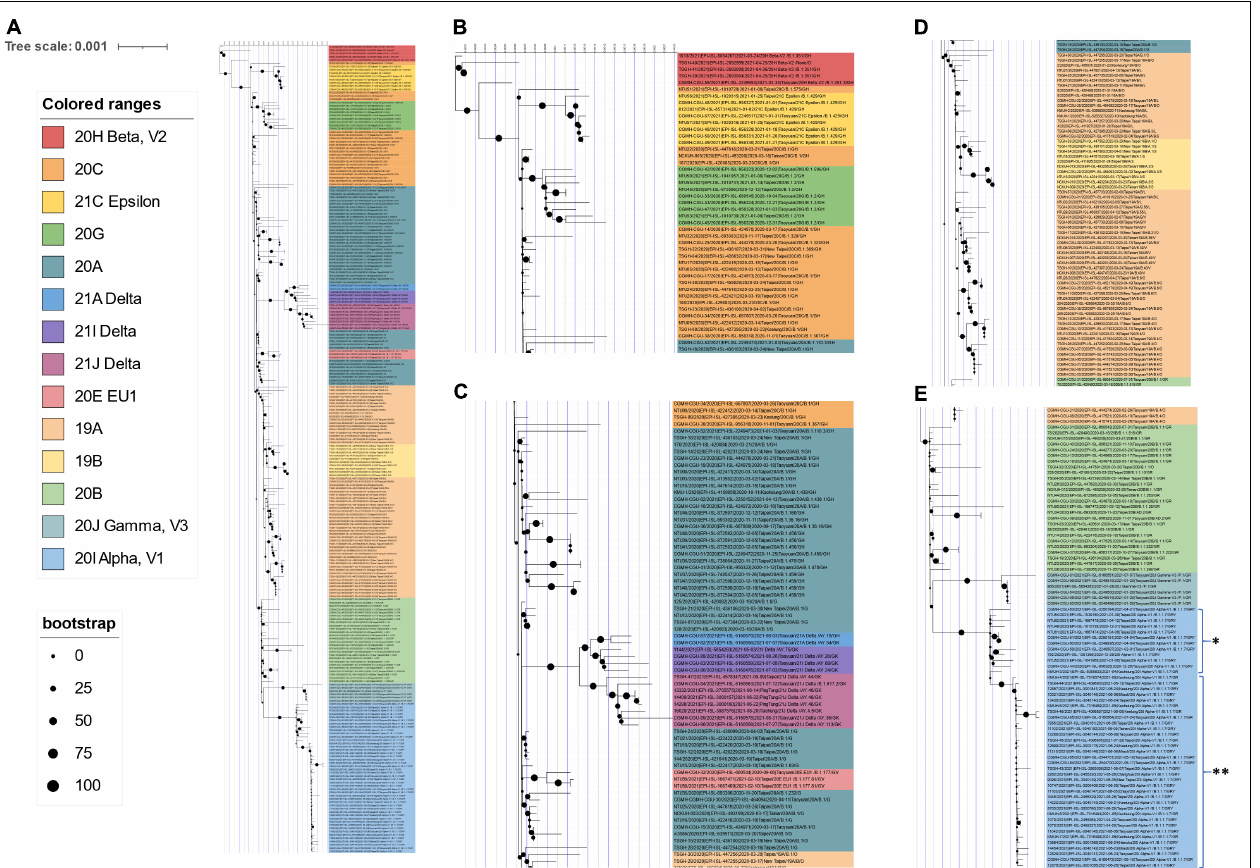
FIGURE 5 | Phylogenetic tree of 247 SARS-CoV-2 genomes collected in Taiwan between January 2020 and December 2021. The phylogenetic analysis was inferred by using the maximum likelihood and fits of 286 different nucleotide substitution models, and the results suggested GTR + F + I as the best-fitting model with the lowest Bayesian information criterion (BIC) scores of 107,672.091 among the 286 models tested. The tree topology was automatically computed to estimate maximum likelihood values. The optimal log-likelihood for this computation was –50,857.073. There was a total of 29,867 positions in the final dataset. The original tree is displayed using iTOL v 6.4.3 (https://itol.embl.de/) (73) with an indicator of bootstrap values and a scale bar. Viruses are shown as the virus name| Accession ID| Collection date| City/Nextstrain_clade/pangolin_lineage/GISAID_clade). (A) An original phylogenetic tree of 247 SARS-CoV-2 sequences obtained from GISAID which samples were collected between January 2020 and December 2021 in Taiwan. (B) A partial tree exhibited phylogenetic correlation between Nextstrain clades 20H beta-V2, 20C, 21C epsilon, and 20G. (C) A partial tree exhibited phylogenetic correlation between Nextstrain clades 20A, 21A delta, 21I delta, 21J delta, and 20E EU1. (D) A partial tree exhibited phylogenetic correlation between Nextstrain clades 19A and 19B. (E) A partial tree exhibited phylogenetic correlation between Nextstrain clades 20B, 20J, and 20I alpha-V1. KMUH-3 was clustered with alpha/B.1.1.7 variant strain sequences without spike M1237I mutation collected between 26 December 2020 and 21 April 2021. KMUH-4 to KMUH-7 were clustered with alpha/B.1.1.7 variant strain sequences with spike M1237I mutation collected between 20 April 2021 and 28 July 2021. ∗ Alpha/B.1.1.7 without spike M1237I mutation; ∗∗ alpha/B.1.1.7 with spike M1237I